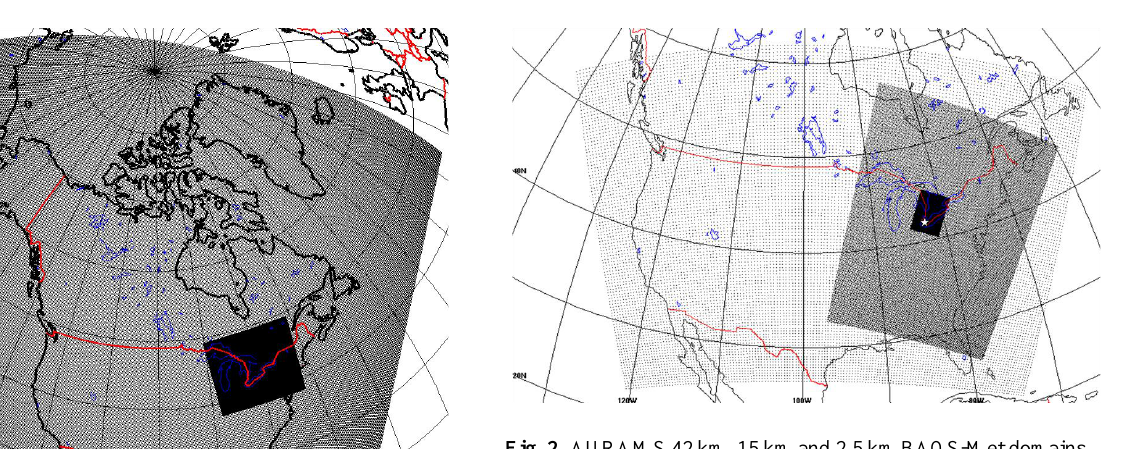
Fig. 2. AURAMS 42km, 15km and 2.5km BAQS-Met